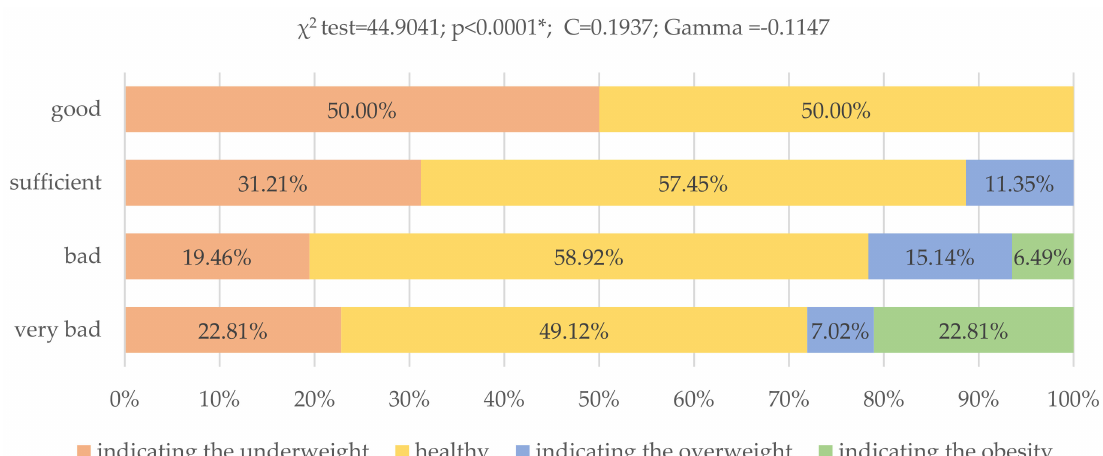
Figure 4. Assessment of nutritional behavior of young Poles and their level of body fat ( N = 399). When assessing the level of body fat, the age and sex of the respondents were taken into account. * Statistically significant differences ( p < 0.05). Source: own study based on the research.